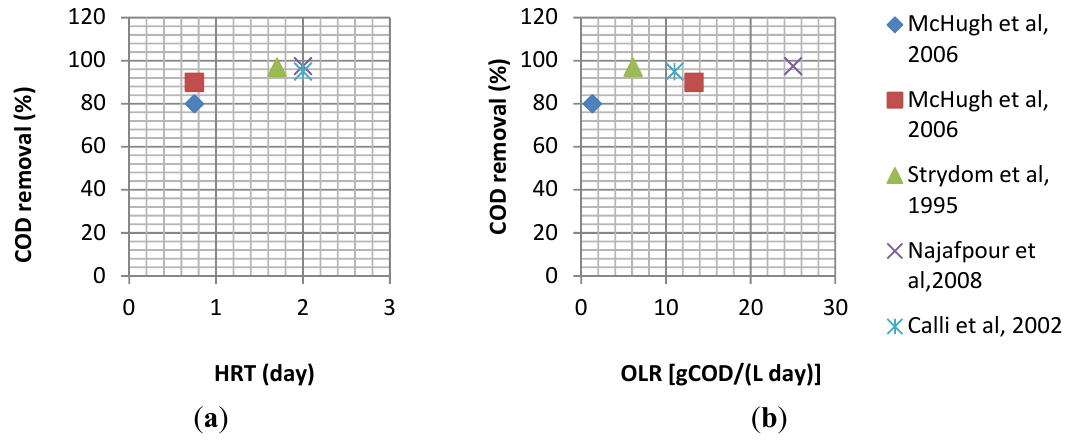
Figure 5. Maximum COD removal versus ( a ) HRT (days) and ( b ) OLR [g COD/(L day)] using hybrid reactors for CW